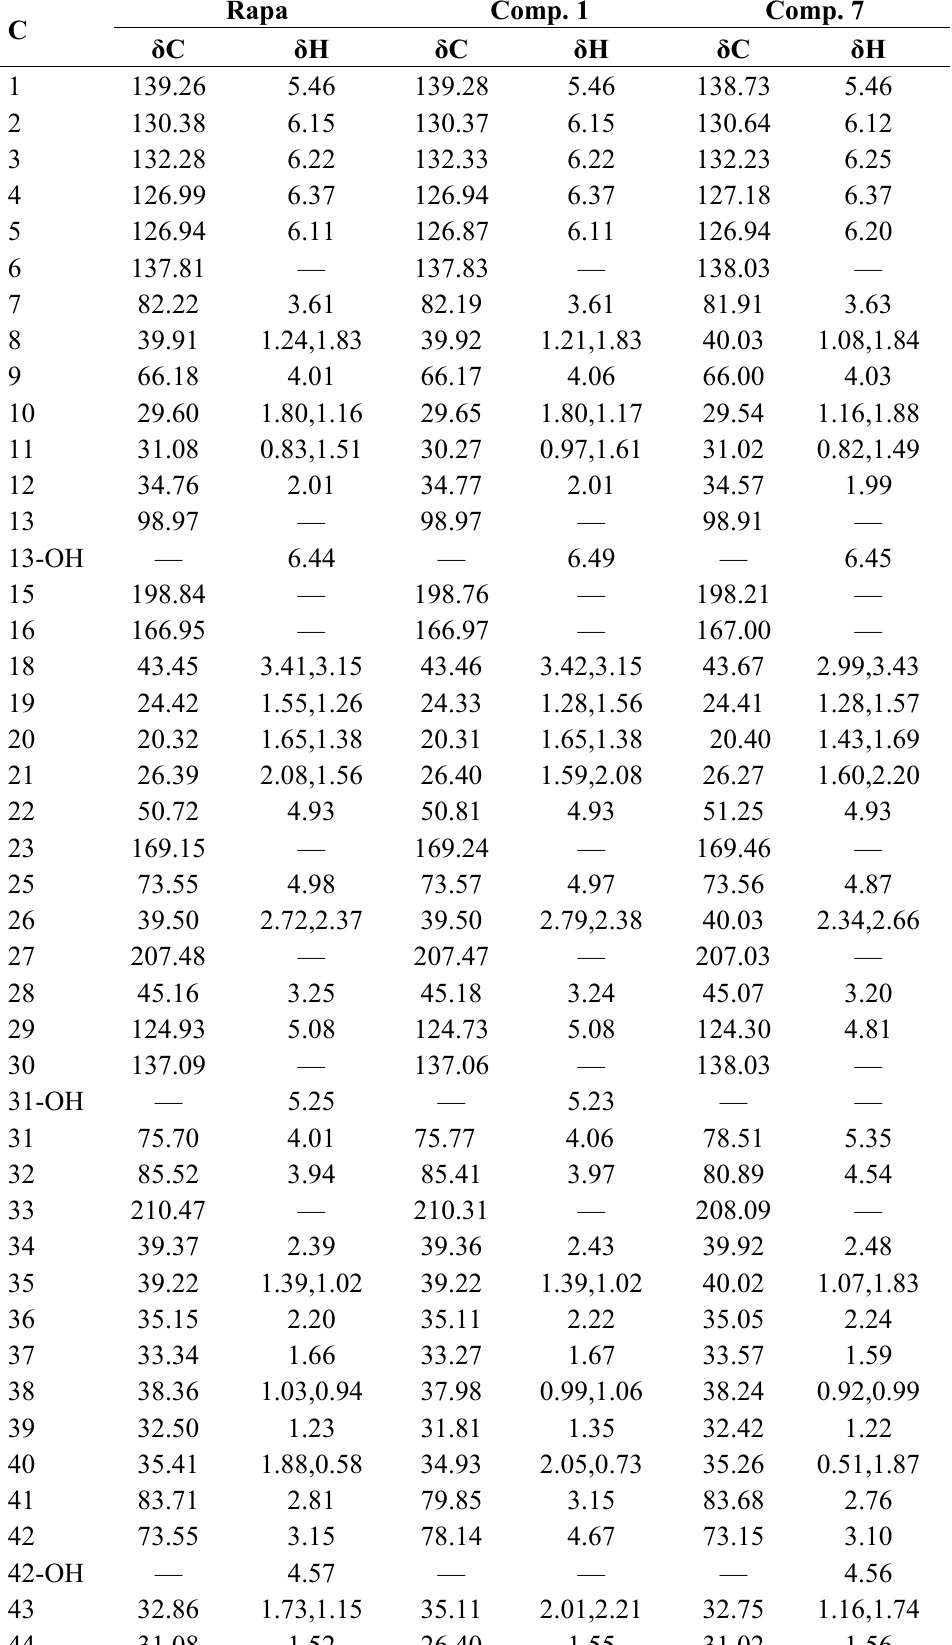
Table 2. 1 H (600 MHz) and 13 C (150 MHz) NMR chemical shifts ( δ , ppm) of Rapa, 1 and 7 in DMSO- d 6